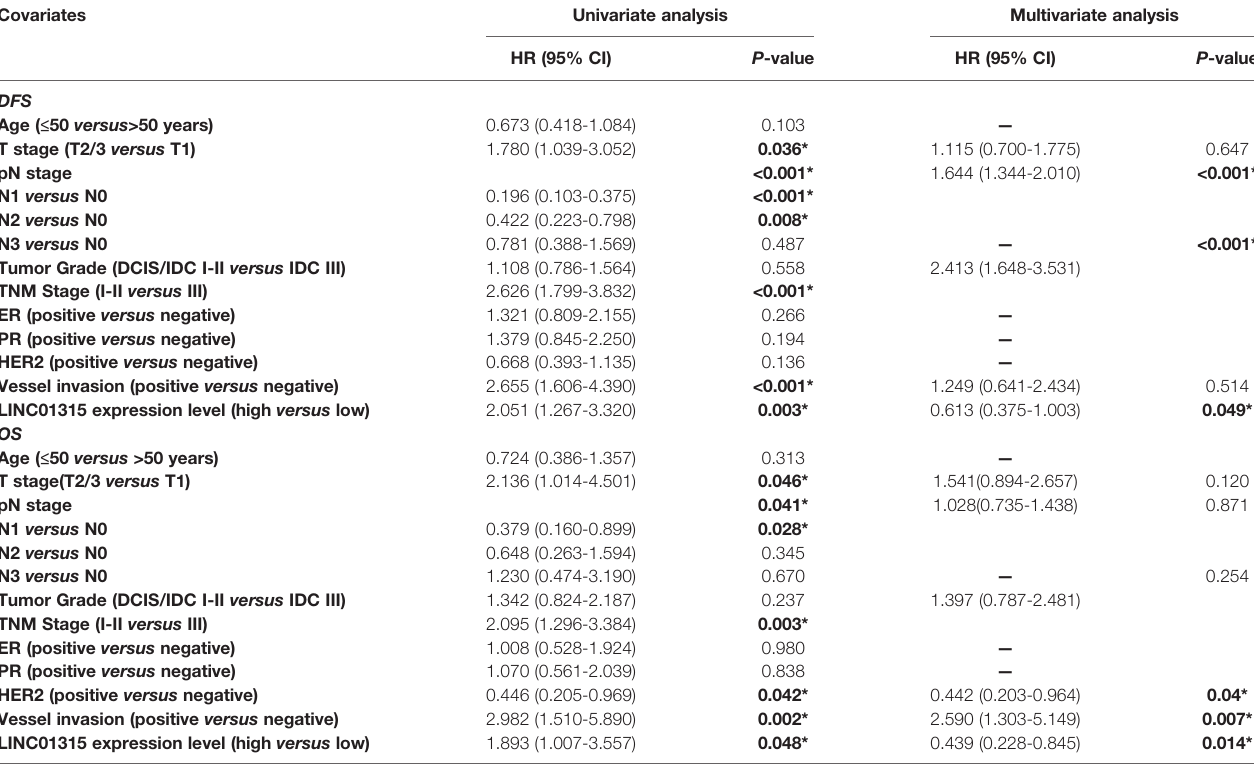
TABLE 2 | Univariate and multivariate Cox regression analyses of DFS and OS in BC patients. Covariates Univariate